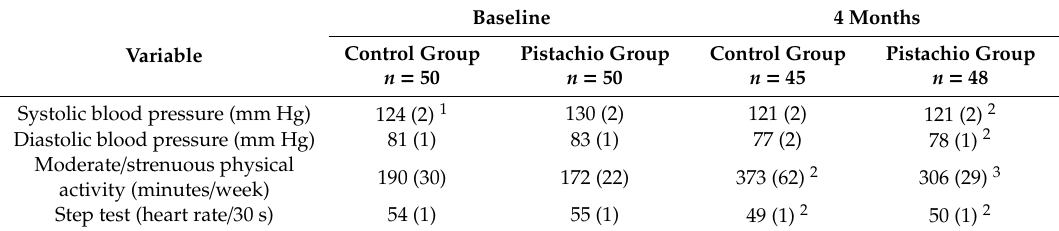
Blood pressure and physical activity variables for study participants in the weight loss intervention.